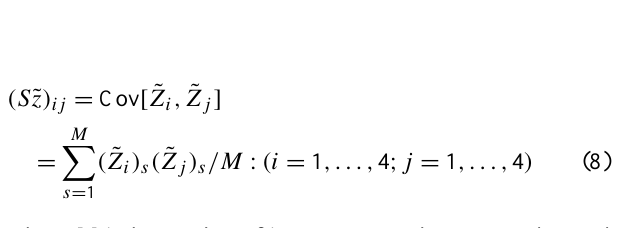
F IG . 12: Schematic of NN trained with input configuration 2. Fig. 12. Schematic of NN trained with input configuration 2.